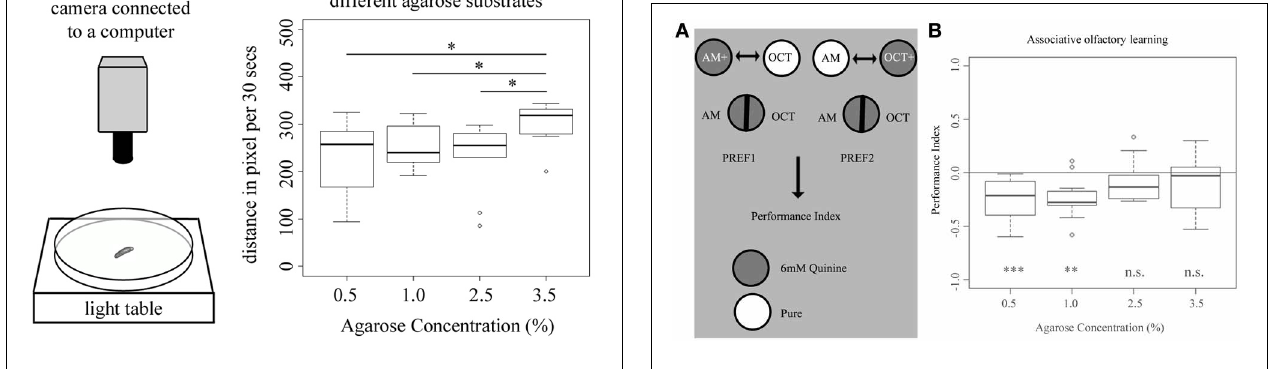
FIGURE 5 | Larval locomotion depends on the agarose concentration of the substrate. (A) Overview of the experimental setup to test for larval locomotion. In detail, individual larvae are positioned on a test plate that is located on a light table to allow for a complete illumination of the test plate. The position of the larva is recorded by a video camera that is mounted above the test plate. (B) Shows the distance that individual wild-type larva crawl within 30s on test plates containing 0.5, 1.0, 2.5, or 3.5% agarose. Tracking was restricted to 30s to exclude that larvae reach the rim of the test plate. At 3.5% agarose concentration larvae significantly increase the distance that they crawl within 30s ( p < 0 . 05 compared to 0.5, 1.0, and 2.5% agarose concentration). Differences between individual groups are shown above the box-plots. Sample size n = 10 for each group. Small circles indicate outliers. ∗ p < 0 . 05.